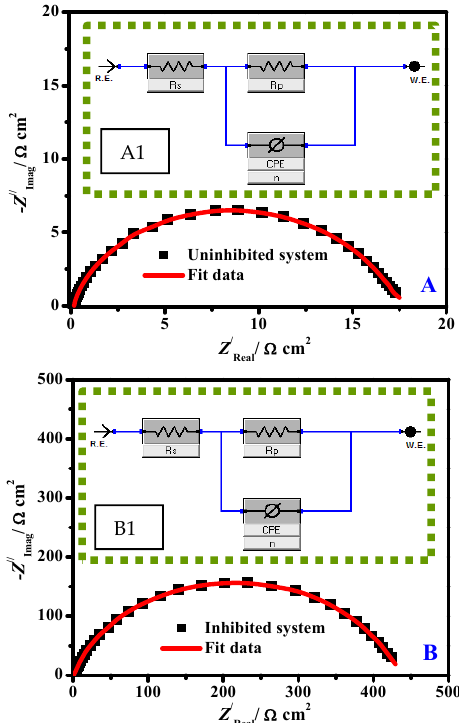
Figure 5. Experimental and fitted Nyquist results of C-steel in the uninhibited system ( A ) and inhibited system ( B ). Inset equivalent circuits model for the phenomena ( A1 , B1 ).